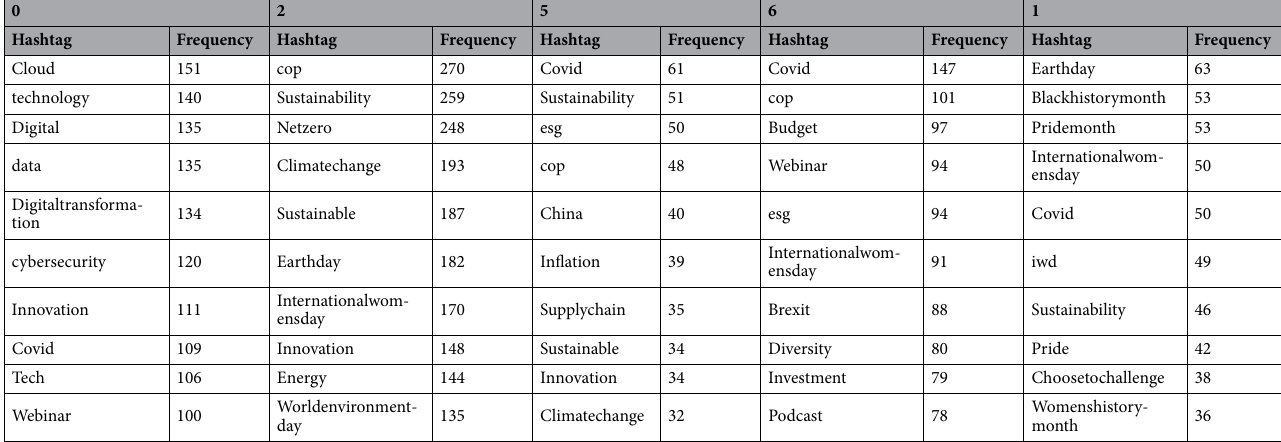
Table 4. Frequency of top 10 most frequent hashtags in the subcommunities with more than 50 nodes in the Cyan community.